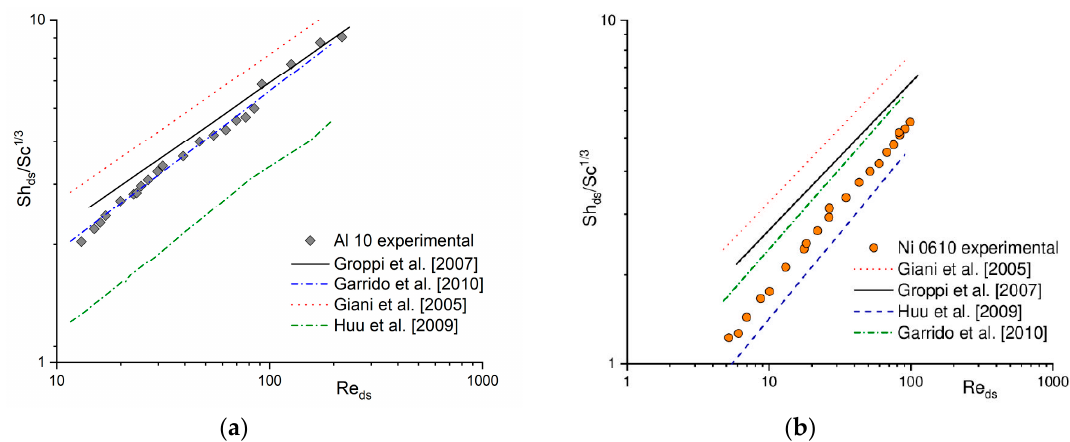
Figure 3. Experimental mass transfer results and those calculated based on the literature correlations for ( a ) Al 10 and ( b ) Ni 0610 foams.